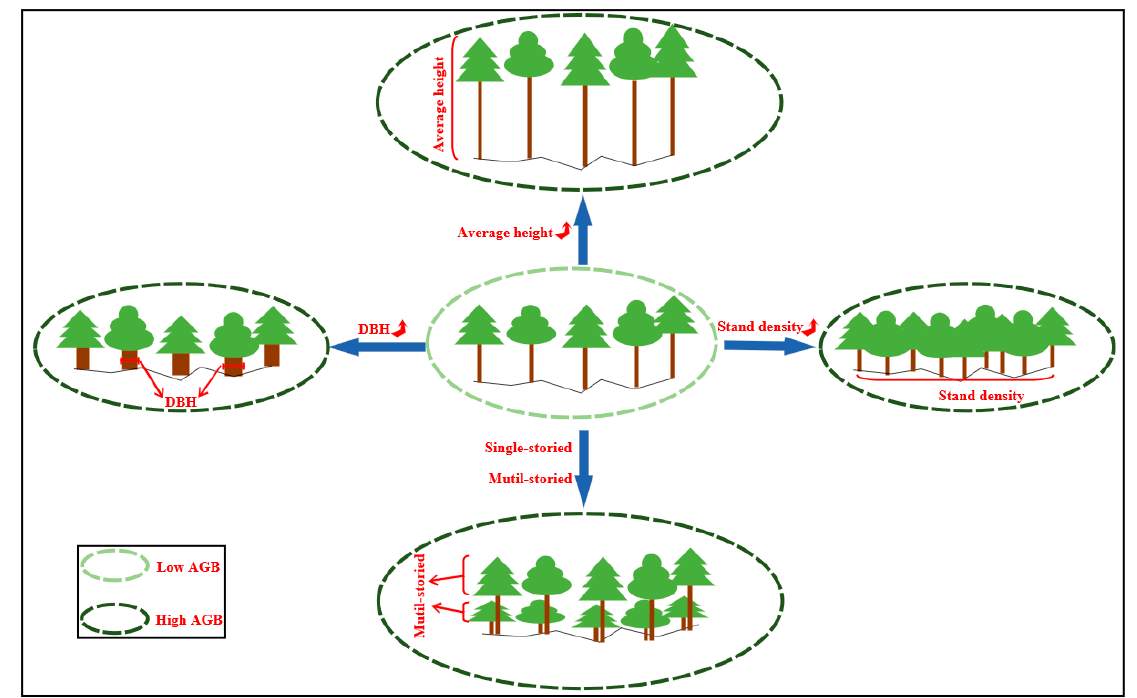
Figure 5. Simplified relationship between factors of dendrometry and forest AGB.